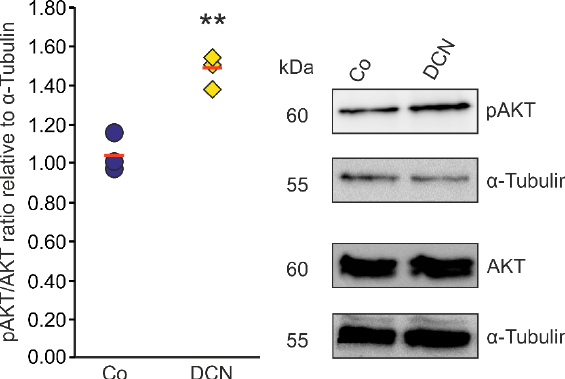
Figure 6. DCN activates AKT signaling in murine ON astrocytes. pAKT/AKT ratio was significantly higher in murine ON astrocytes treated with 25 nM of DCN for 6 h (1.47 ± 0.09, n = 3, p ≤ 0.01) in comparison to untreated controls (1.04 ± 0.09, n = 3) speaking for an activation of the pAKT/AKT signaling pathway in this cell type. pAKT and AKT were normalized to α -Tubulin. ** are significant with p ≤ 0.01.